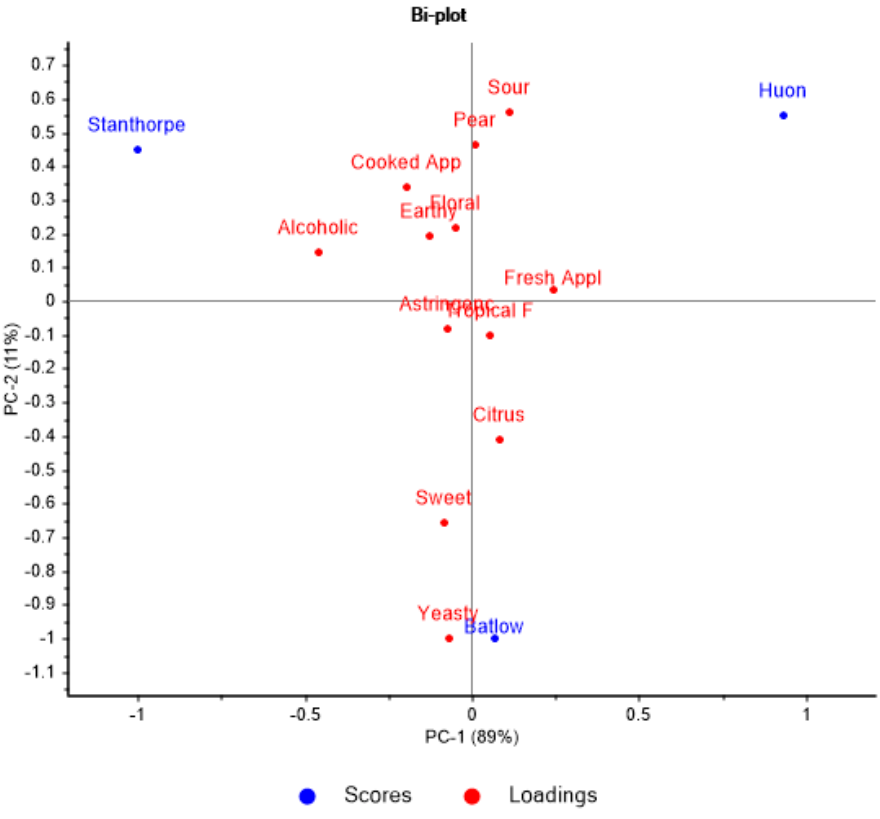
Figure 1. Scores plot for principal component analysis (PCA) of sensory attributes analysed on ciders made using “Fuji” apples from Huon Valley, Batlow and Stanthorpe ( n = 48 per region). Table 4. TPC (TPI), pH, TA (malic acid mg/mL), TSS ( ◦ Brix) and alcohol by volume (ABV) results for Fuji apples from all three regions for both juice and cider. Different letters denote significant differ- ences between means at p ≤ 0.05. (No significant difference is denoted by “NS”, ** is p = 0.001–0.01 and *** p ≤